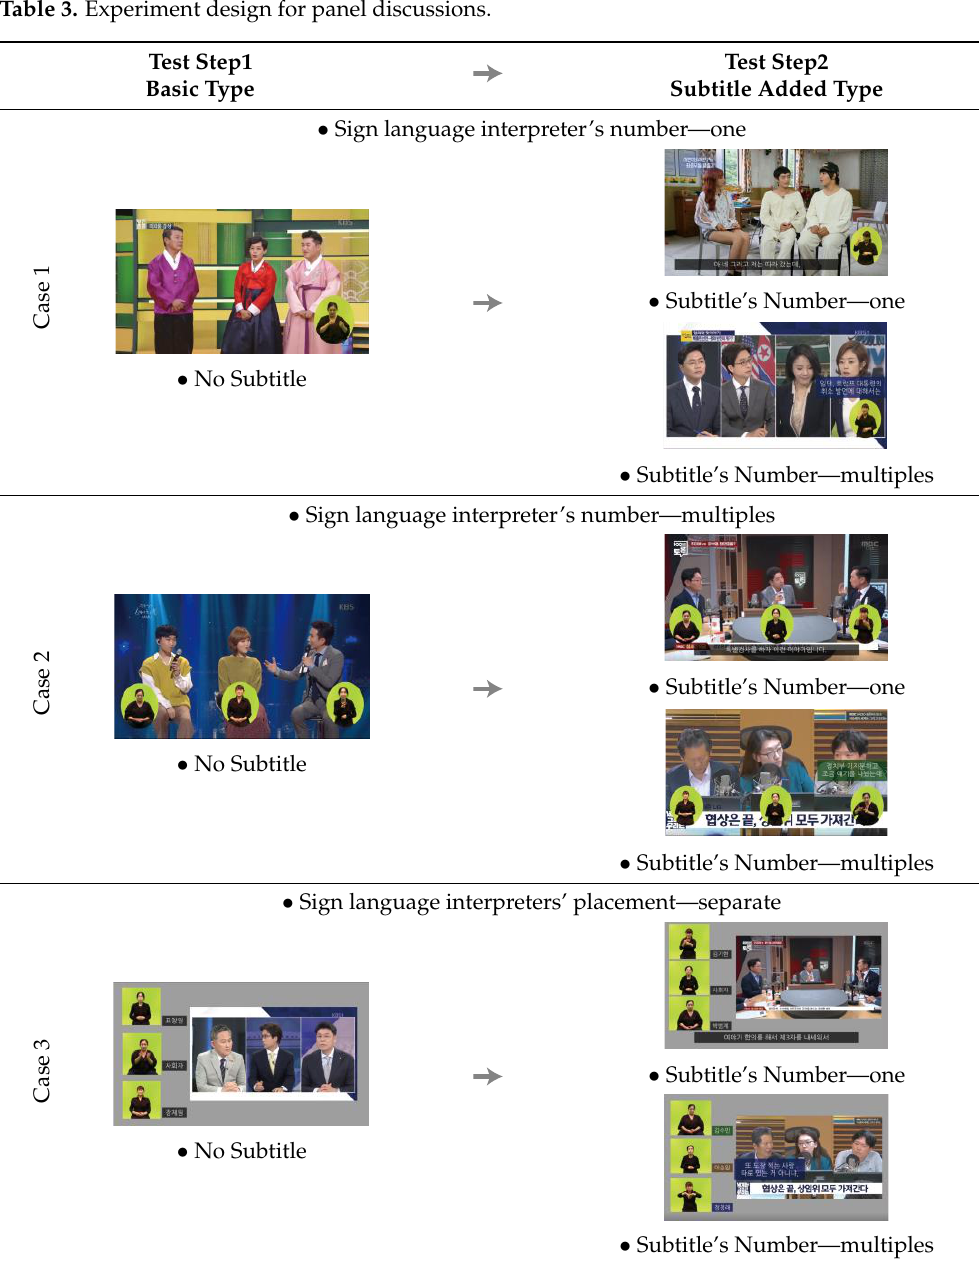
Table 2. Experiment design for news.